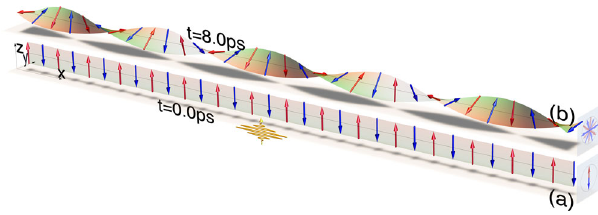
Fig. 1 Driving chiral antiferromagnetism by a short laser pulse. a Initial antiferromagnetic con fi guration in zx plane. Red and blue arrows represent initial up and down moments in the collinear antiferromagnetic ground state of the system. The yellow wavy line denotes the laser pulse polarised along the x -direction. b Following a complex intertwined dynamics of electrons and localised spins, a stable spin spiral state of the system is achieved (see Supplementary Movie 1 and Supplementary Note